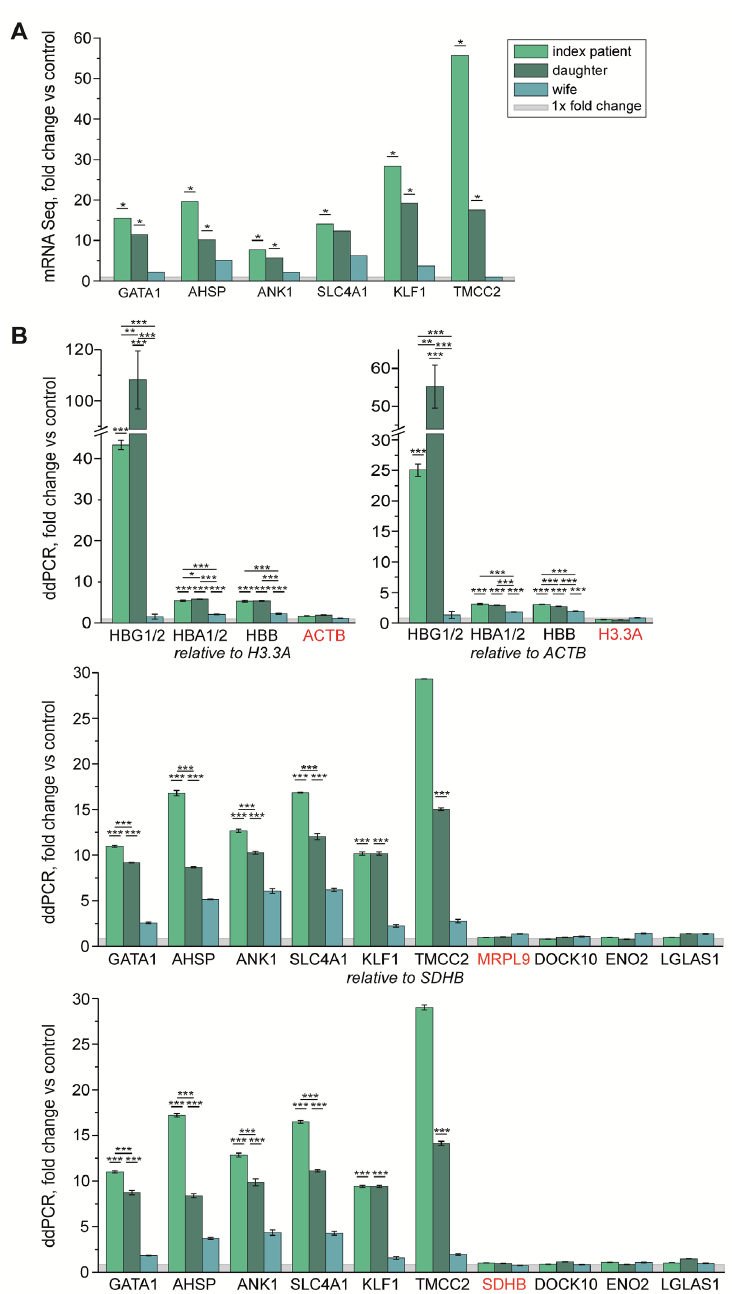
Figure 5. ( A ) Fold change vs. one control and of selected significantly deregulated genes detected in transcript profiling of the index patient (light green), his daughter (dark green), and his wife (blue). * = q < 0.05 (fitted for multiple testing). The 0–1-fold change is highlighted as a gray area. ( B ) ddPCR confirmation of significant expression differences noticed in NGS-based transcript profiling and of further potentially interesting genes missed by the analyses. Each measurement was set into relation to a housekeeper ( H3.3A, ACTB, MRPL9, SDHB ), and an additionally evaluated control gene is highlighted in red. The fold change was chosen for easy-to-understand representation, but the statistical significance levels shown were calculated on the basis of the relative transcription levels of the respective individuals set in comparison to three control subjects. Statistically significant differences in control genes were defined as naturally occurring and used as a detection limit. * = p < 0.05, ** = p < 0.01, *** = p < 0.001, light green = index patient, daughter = dark green, wife = blue, gray = 1 × fold